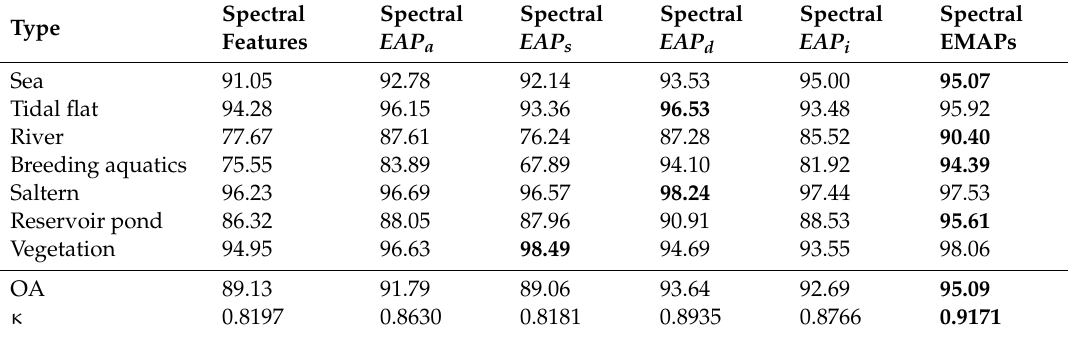
Table 5. Classification accuracy obtained using spectral and di ff erent spectral–spatial features (Jiaozhou Bay wetland). EAP—extended attribute profile; EMAP—extended multi-attribute